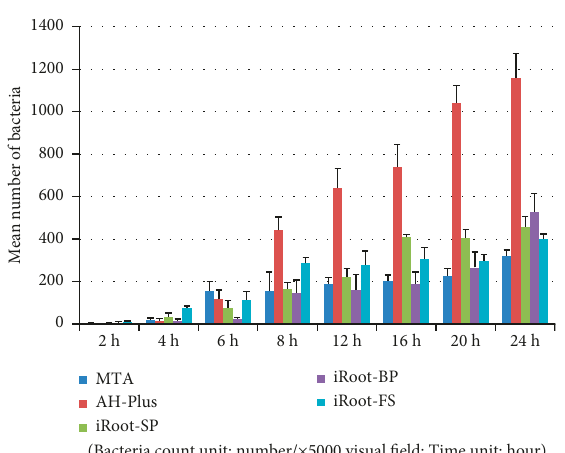
Figure 8: Porphyromonas gingivalis group (electron microscopy counting).